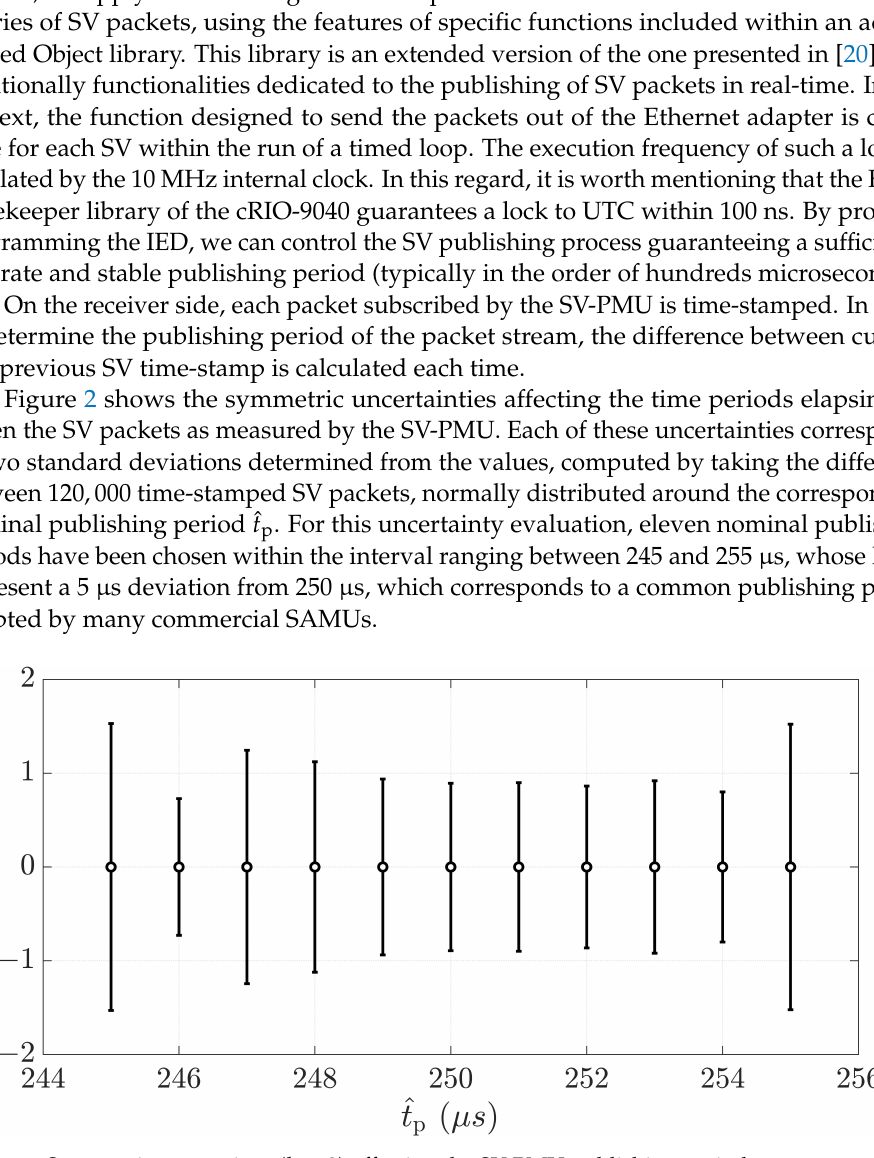
Figure 2. Symmetric uncertainty ( k = 2) affecting the SV-PMU publishing periods measurements as a function of nominal publishing periods ranging from 245 to 255 µ